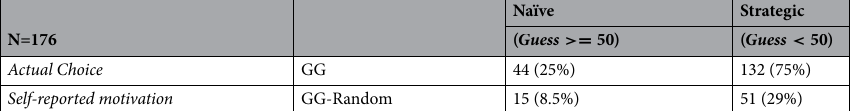
Table 4. Guessing game: actual choice and self-reported motivation. Actual Choice reports the choices of all participants in the guessing game. Self-reported motivation describes data related to the motivation of the choice in the guessing game, where GG-Random describes those subjects that explicitly reported to have hazarded a guess, divided among those making a naïve choice in the GG and those making a Strategic choice in the GG. Percentages are out of